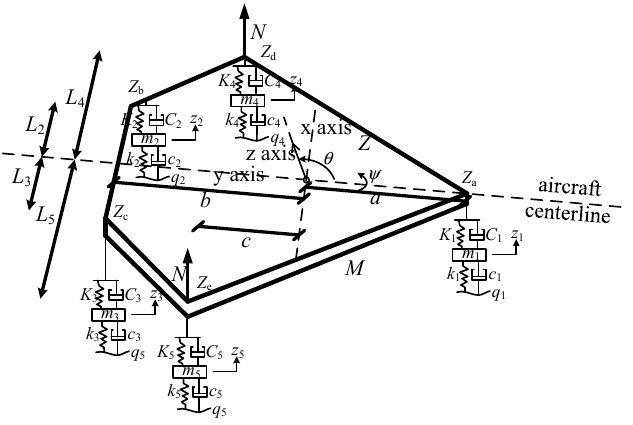
Figure 1. A mathematical model of a “five-point-contact” aircraft with six degrees of freedom. With respect to vertical motion, the reed mass of the large aircraft is M (kg); N is the lift force acting on the large aircraft (kN); and Z is the vertical displacement of the entire aircraft (m). For the front wheels, left rear landing gear, right rear landing gear, left rear wing wheel landing gear, and right rear wing wheel landing gear, the unsprung masses are m1, m2, m3, m4, and m5 (kg), respectively; the stiffness coefficients are K1, K2, K3, K4, and K5, respectively; and the damping coefficients are C 1 , C 2 , C 3 , C 4 , and C 5 , respectively, and incentives for the existence of uneven roads are q 1 , q 2 , q 3 , q 4 , and q 5 , respectively. The vertical displacements (m) of the sprung masses and the unsprung masses of the front wheels, left rear landing gear, right rear landing gear, left rear wing wheel landing gear, and right rear wing wheel landing gear are Z a , Z b , Z c , Z d , and Z e , respectively, and z 1 , z 2 , z 3 , z 4 , and z 5 ,